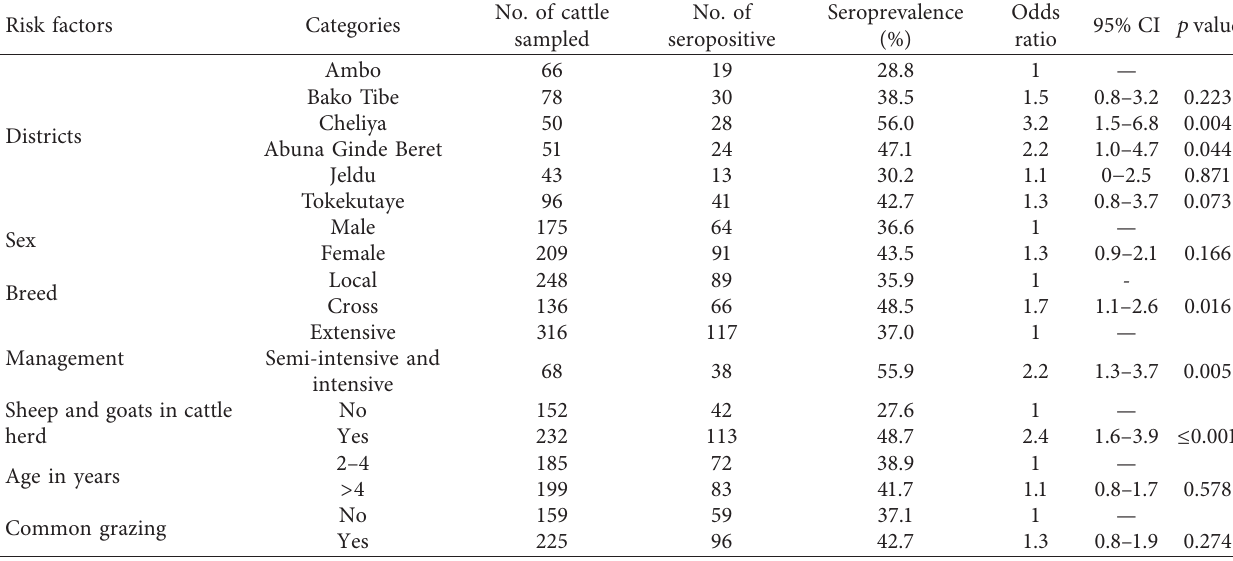
Table 1: Univariable logistic regression analysis of potential risk factors associated with the seropositivity of bovine FMD in West Shewa